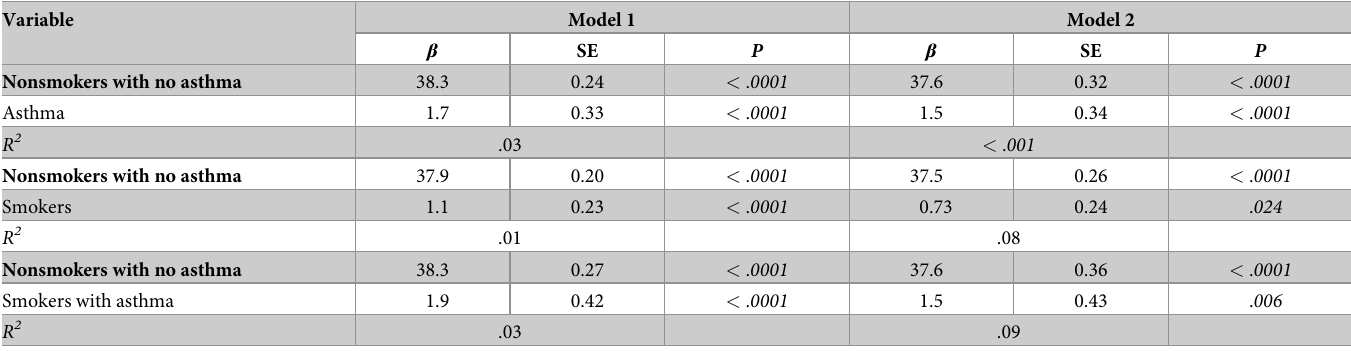
Table 4. Associations of asthma and smoking with hip circumference. Variable